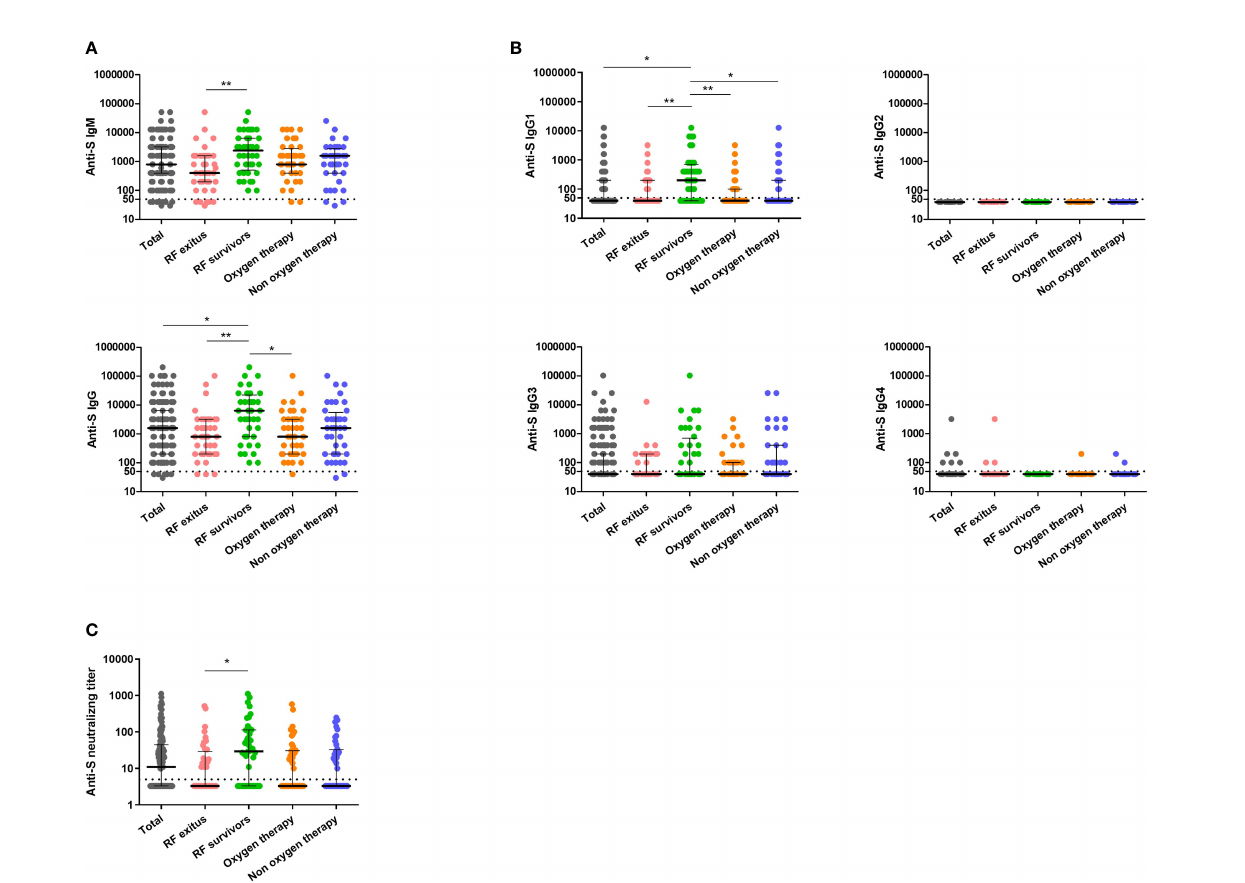
FIGURE 1 | Analysis of antibody levels and neutralizing activity against SARS-CoV-2 S protein in serum samples from COVID-19 patients. Anti-S IgM, anti-S IgG (A) anti-S IgG1, anti-S IgG2, anti-S IgG3 and anti-S IgG4 (B) and neutralizing titers (C) are indicated for the total cohort of patients (grey circles, n = 160) and the different disease severity groups: RF non-survivors (pink circles, n = 40), RF survivors (green circles, n = 40), oxygen therapy (orange circles, n = 40) and non-oxygen therapy (blue circles, n = 40). Cutoff value to determine positive (above) and negative (below dashed line) samples is indicated. Black lines represent medians and interquartile range. Statistical signi fi cance was determined by the non-parametric Kruskall-Wallis and Dunn ’ s Multiple Comparison tests, where * p < 0.05 and ** p < 0.001. RF indicates respiratory failure. Y axis is represented by logarithmic